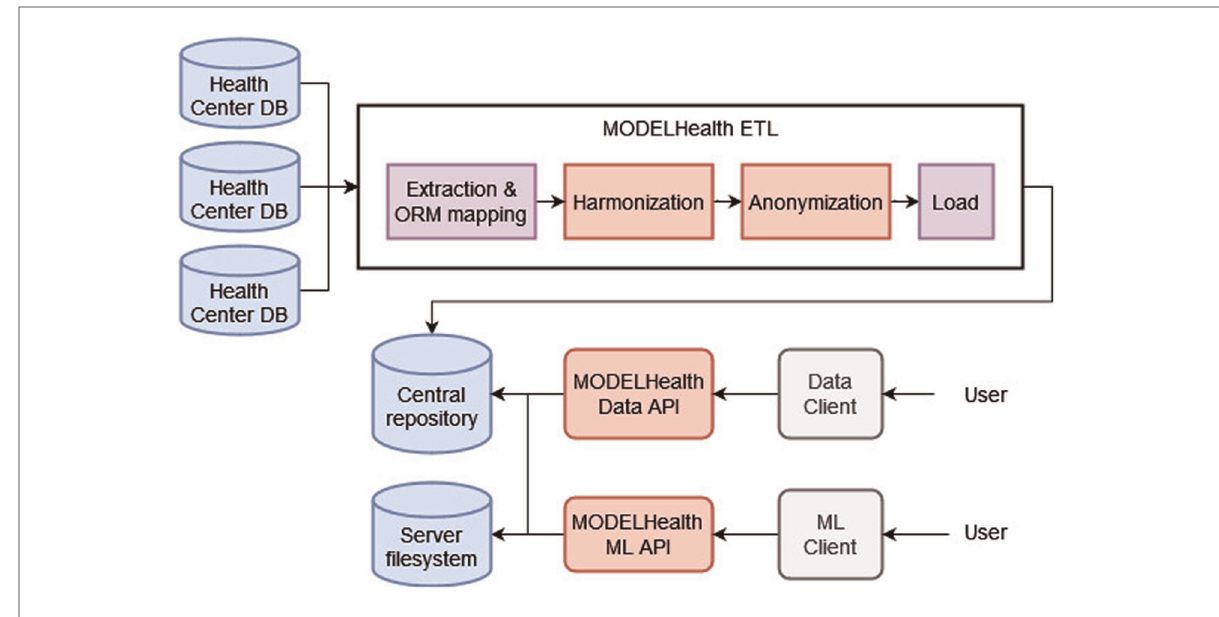
FIGURE 1 The components of the MODELHealth